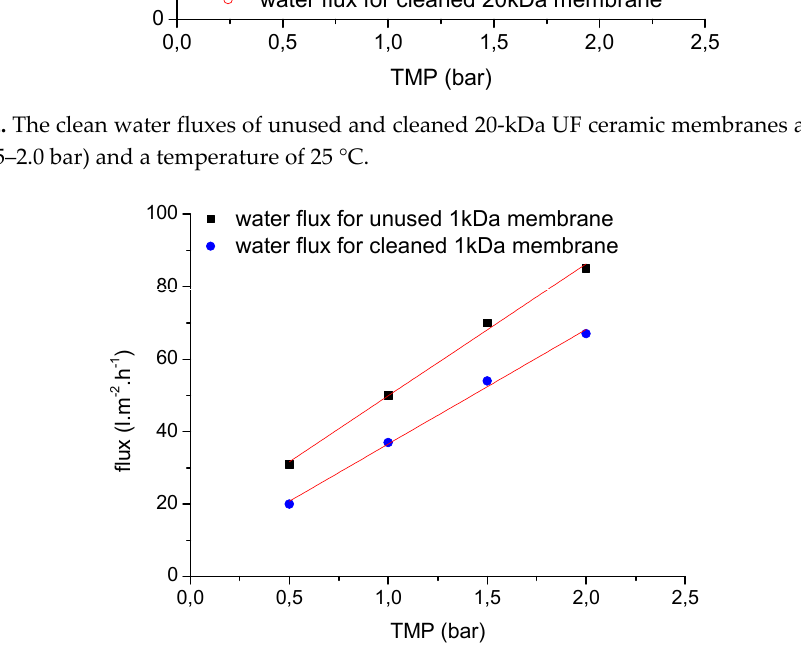
Figure 13. The clean water fluxes of unused and cleaned 1-kDa NF ceramic membranes at different TMPs (0.5–2.0 bar) and a temperature of 60